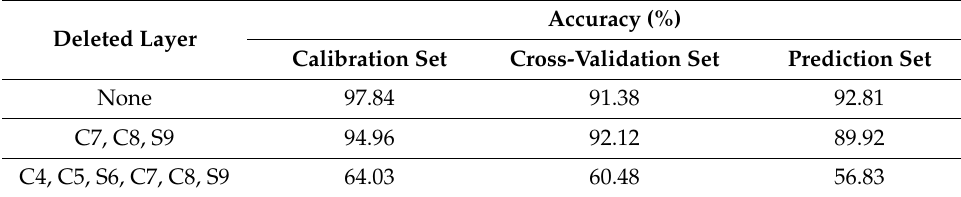
Figure 2. Flow chart of 1D-CNN. Table 1. The classification accuracies of 1D-CNN with different